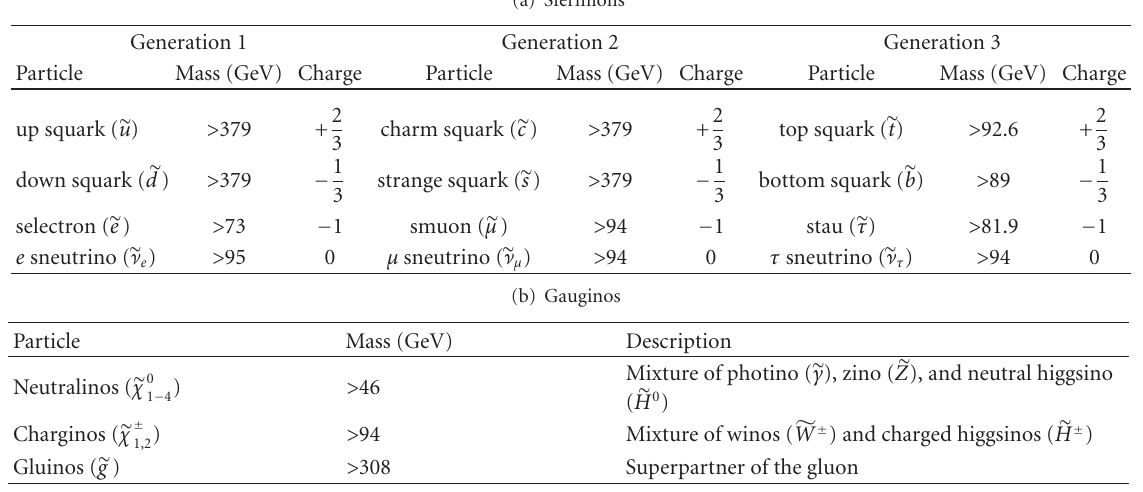
Table 2: The particles predicted by a supersymmetric extension of the Standard Model. Limits on the masses of particles as last reported by the Particle Data Group